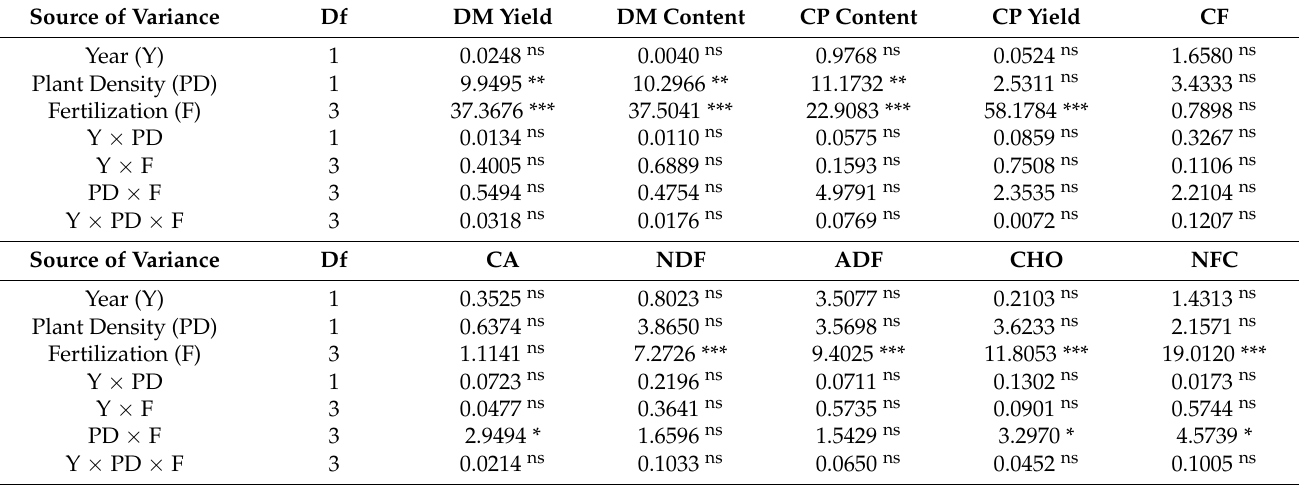
Table 1. Combined analysis of variance ( F ) for all measured traits of black mustard biomass in two experimental years.